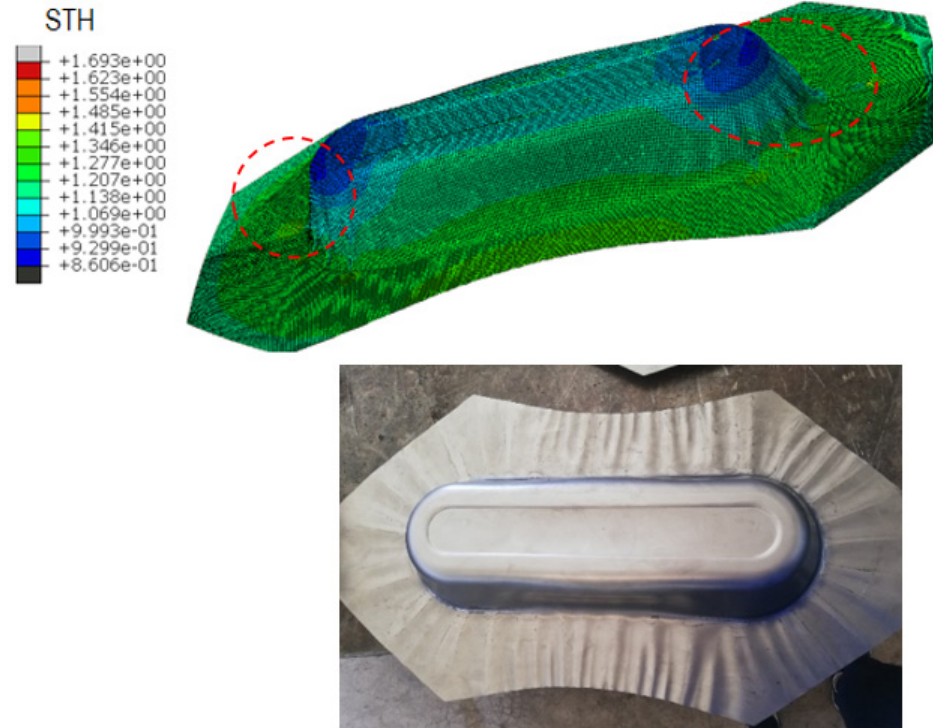
Figure 7. First test: Experimental and Numerical results of car fuel tank deep drawing.